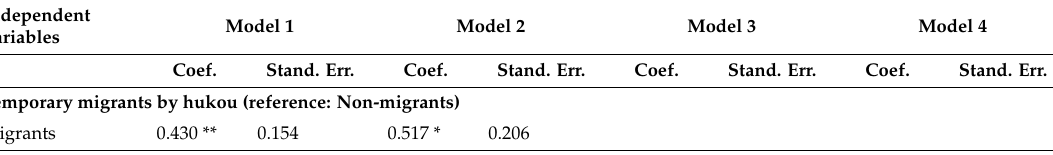
Table 2. Results of the binary logistic regressions ( N =